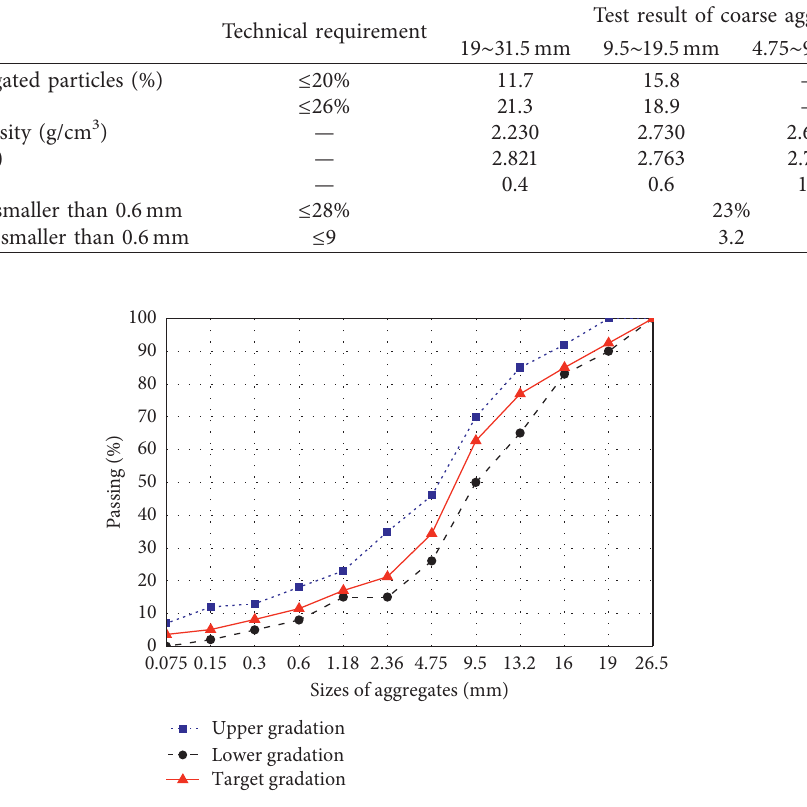
Figure 1: Gradation curve of limestone aggregates. Table 3: Vibration compaction test results of cement-treated